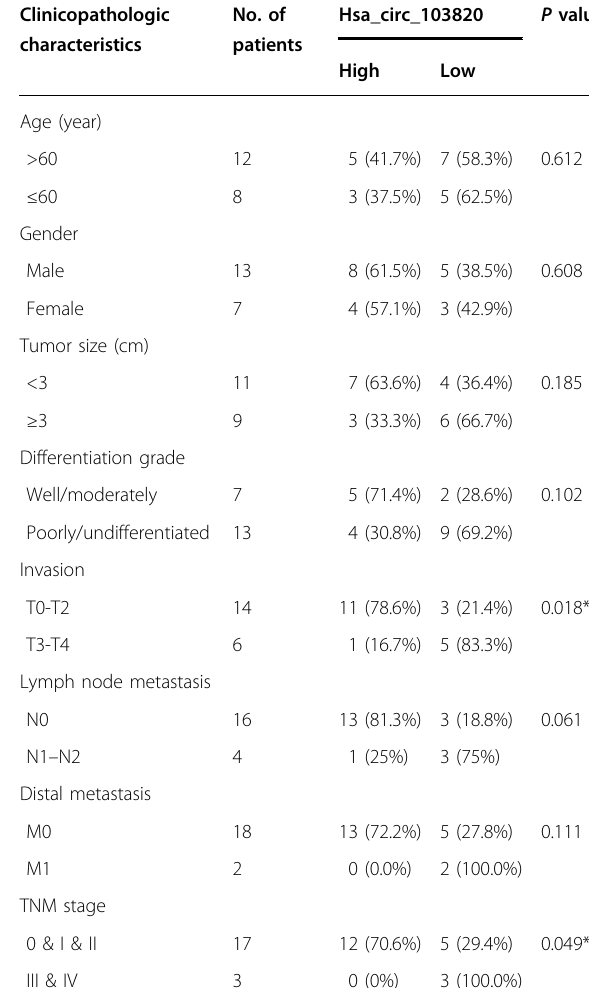
Table 1 The correlation analysis between LIFR expression and clinicopathologic characteristics in lung cancer. Clinicopathologic characteristics